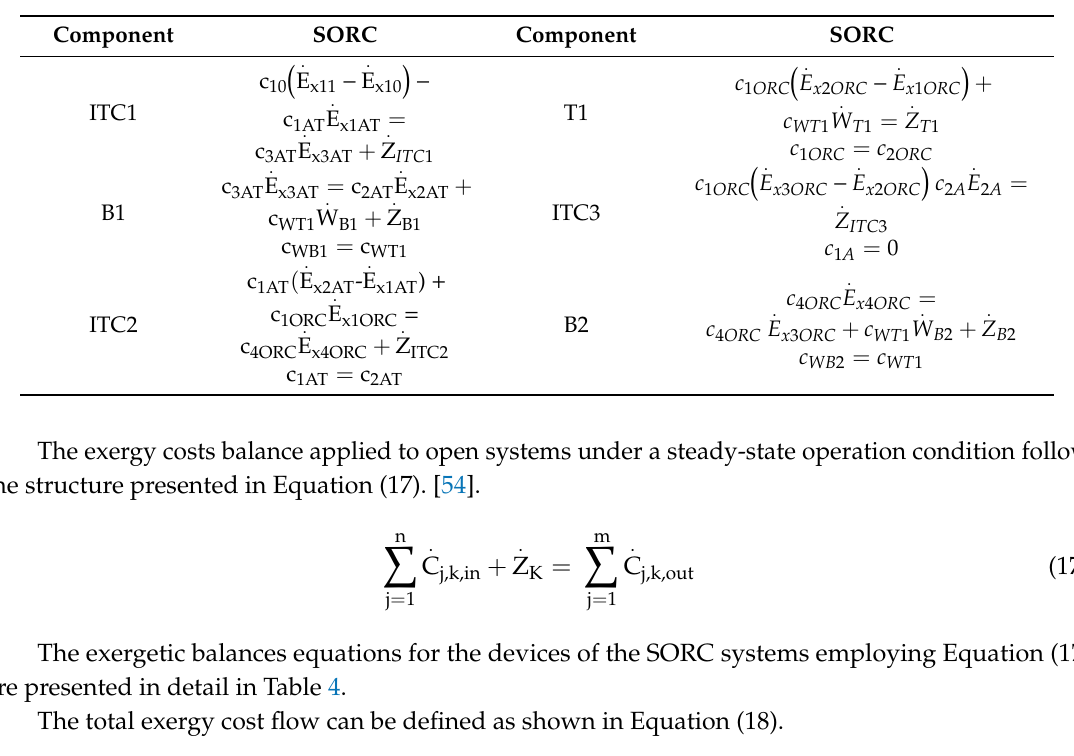
Table 4. Exergetic cost balances of system